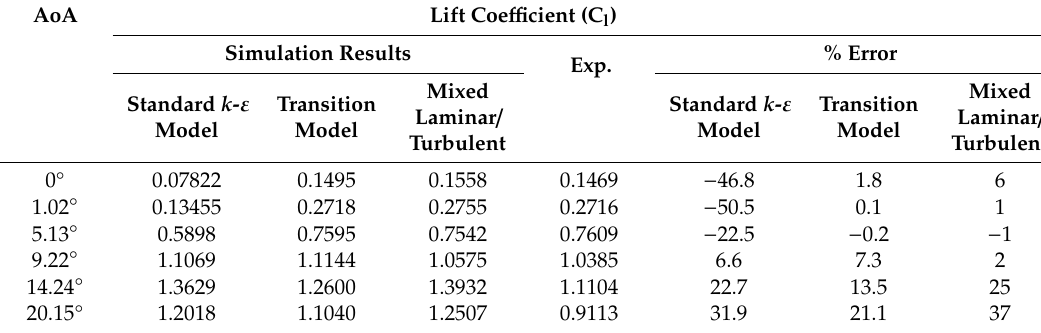
Table 3. Comparison between the simulation and experimental results for the lift coe ffi cient at